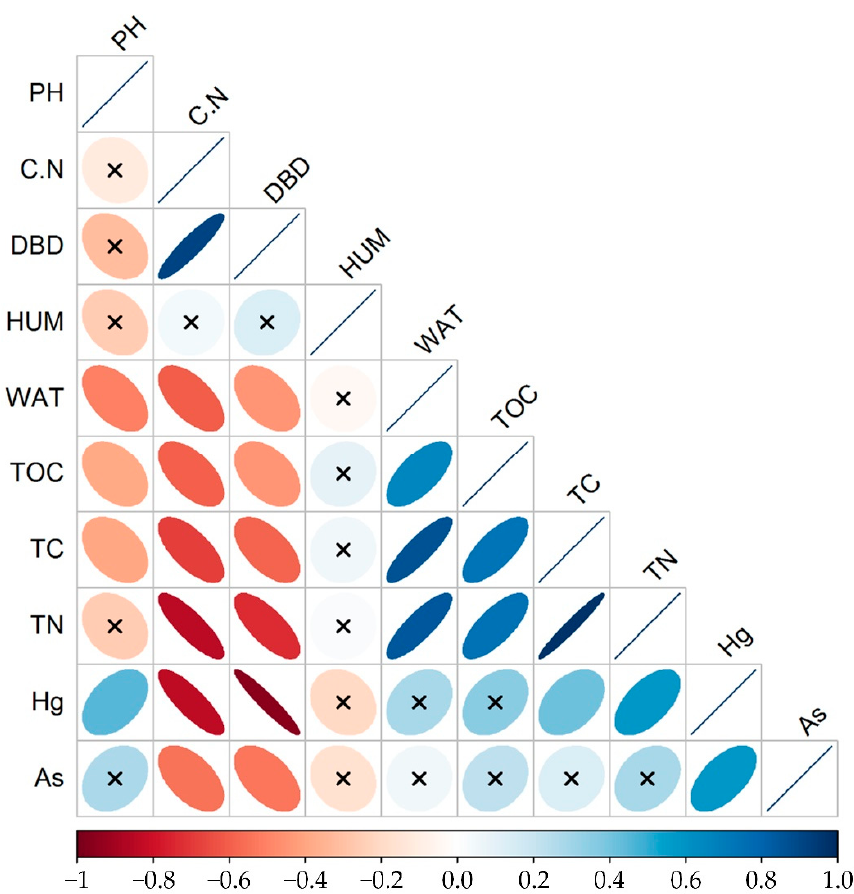
Figure 5. Correlation analysis between accumulation rates of As and Hg and other soil physicochemical properties, respectively. Blue and red indicate positive and negative correlations, respectively. The depths of the colors indicate correlation coefficients with either higher (darker) or lower (lighter) values. Shapes more elliptical or round represent lower or higher values of the significance level of p , respectively. The cross ( × ) represents the significance level p ≥ 0.05. PH, C.N, DBD, WAT, TOC, TC, TN, Hg, and As represent pH, the ratio of total carbon content to total nitrogen content, dry bulk density, mass water content, total organic carbon content, total carbon content, total nitrogen content, and accumulation rates of Hg and As, respectively.